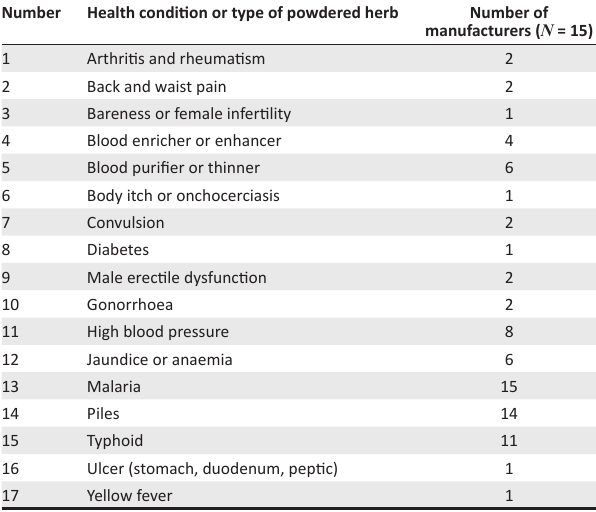
TABLE 2: List of health conditions indicated for traditional oral powdered herbal formulations manufactured and marketed in Ogbomoso, Nigeria.